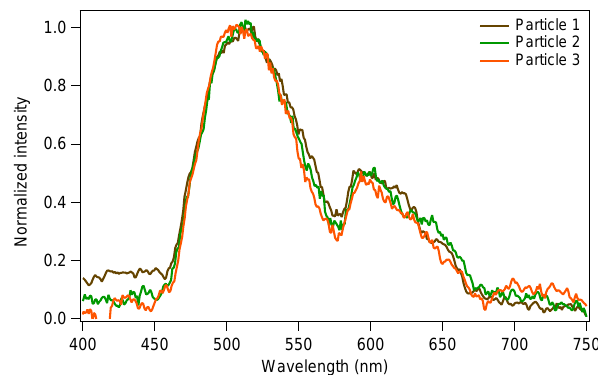
Figure 3. Fluorescence spectra of three individual paper mulberry pollen particles ( Broussonetia payrifera ) illuminated by 405nm diode laser (Fig. 2d). Emission wavelength was calibrated using 405 and 650nm laser points (Fig. 2b). All spectra were normalized to 1.0 maximum peak